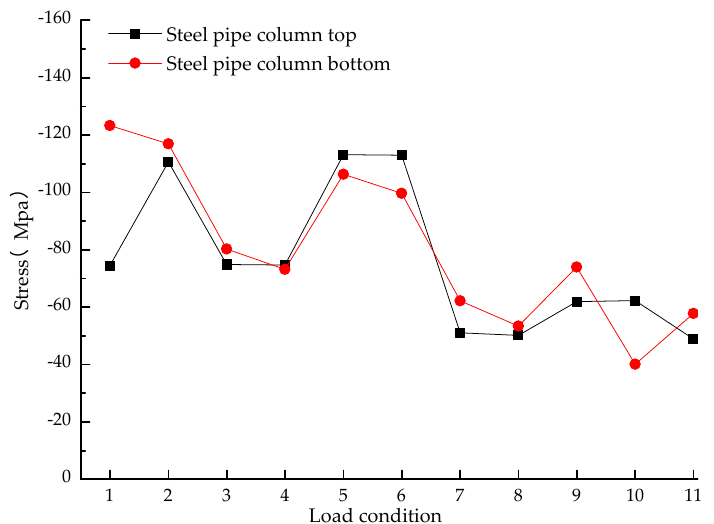
Figure 14. Location and number of steel pipe columns of the tower at the right bank.